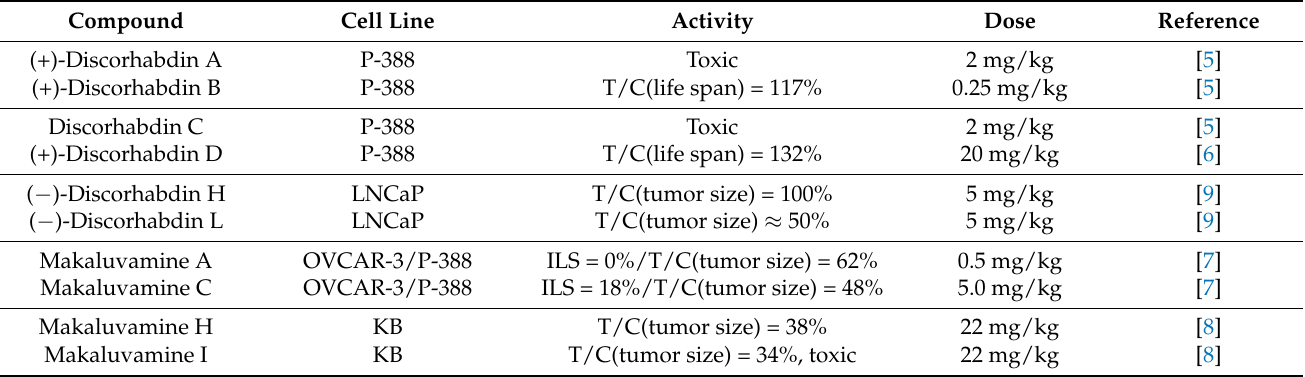
Table 1. Anti-tumor activity of natural pyrroloiminoquinones against tumor xenografts in mouse models.